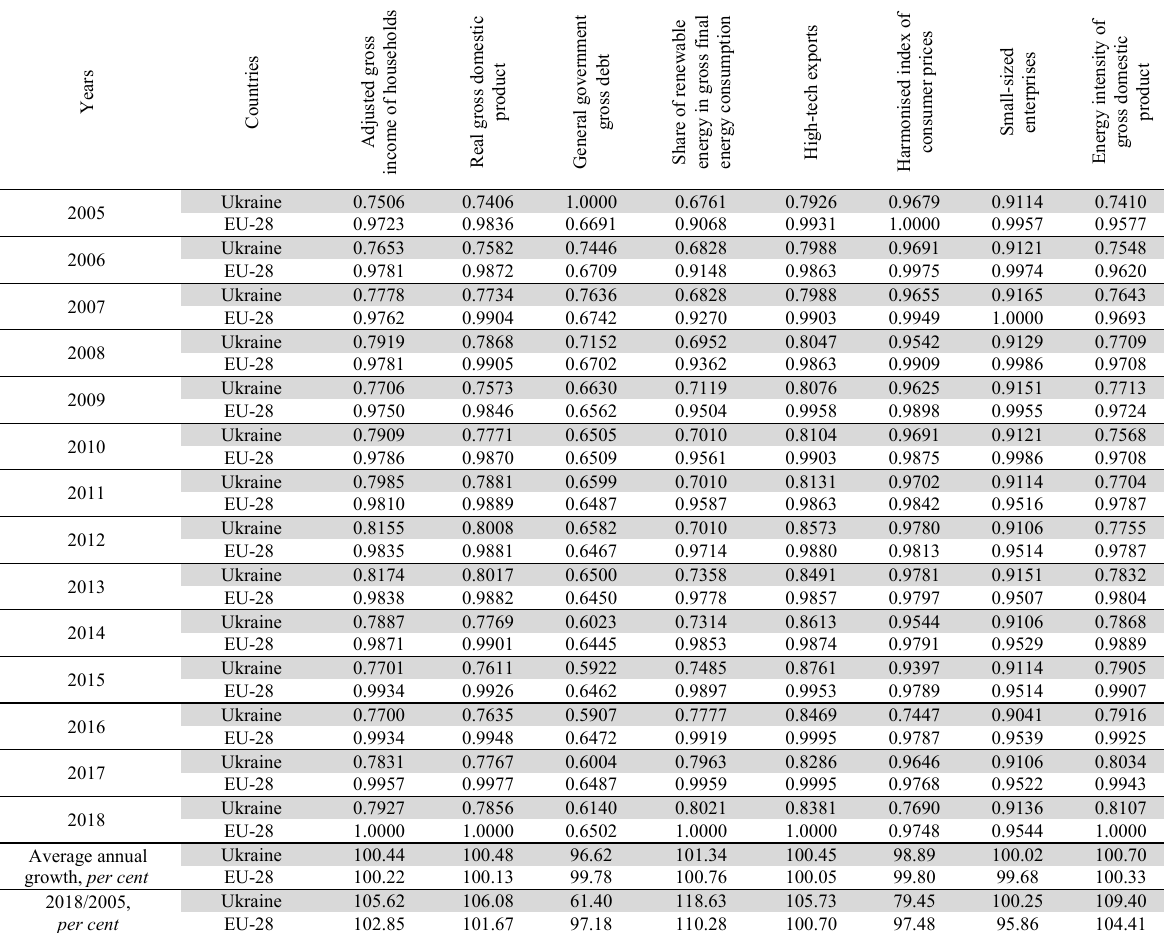
Indices of economic development indicators in Ukraine and the EU-28, 2005-2018